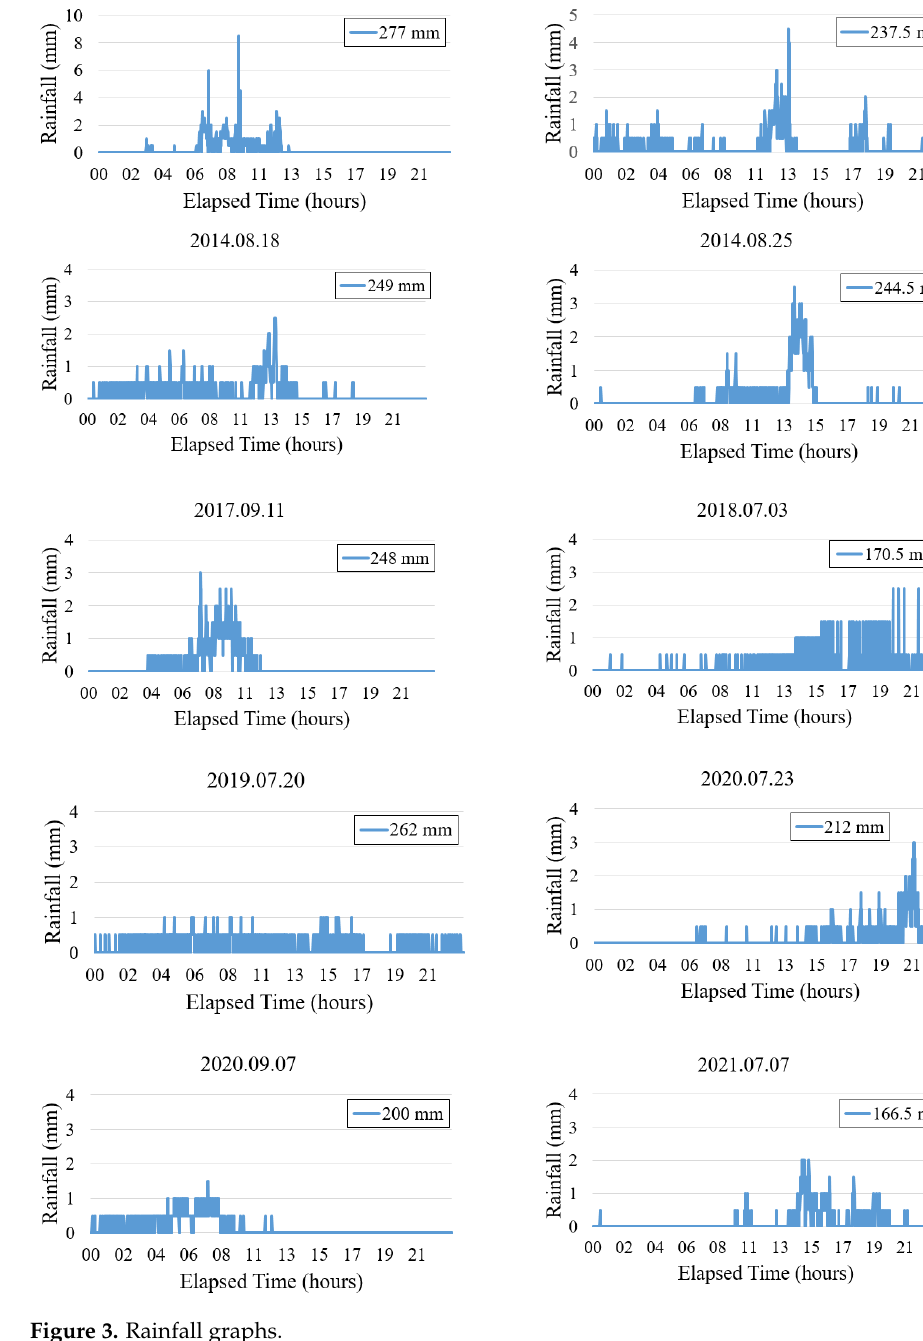
Figure 3. Rainfall Figure 3. Rainfall graphs.